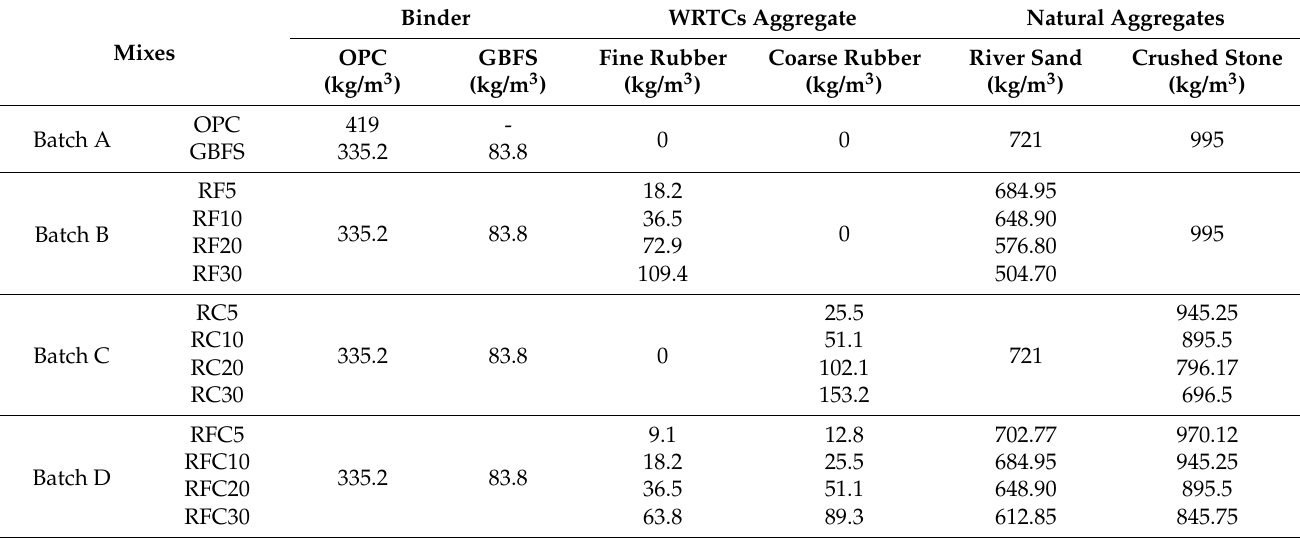
Table 4. The mix design of the granulated blast furnace slag (GBFS) and WRTCs modified concrete.